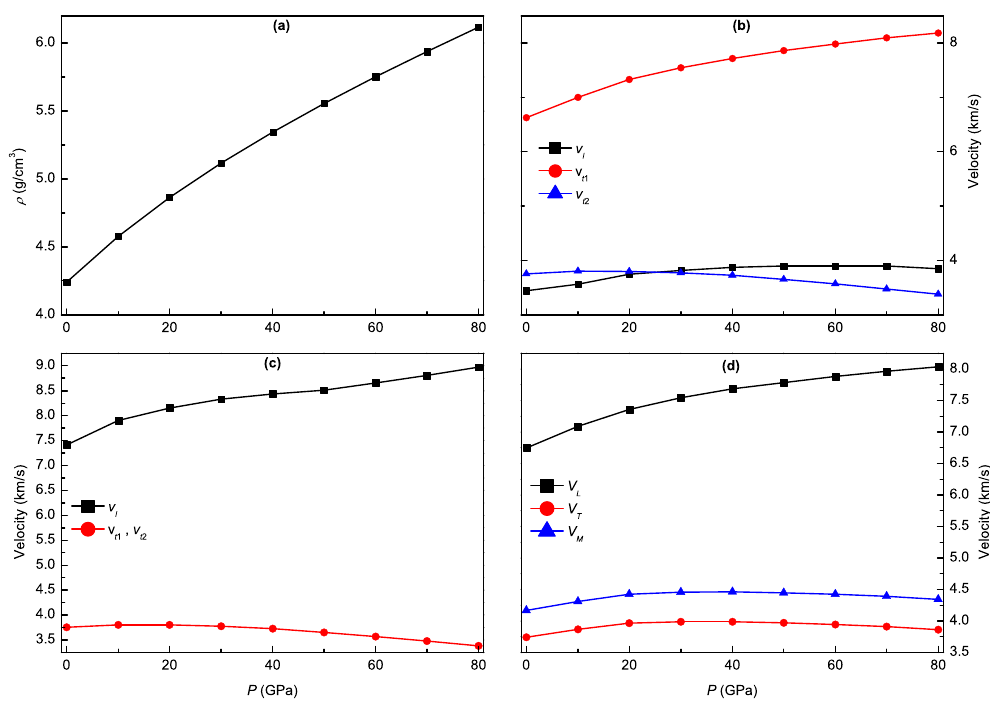
Figure 10. Mass density ρ ( a ), longitudinal and transverse sound velocities v l , v t 1 , and v t 2 in the [100] ( b ) and [001] ( c ) principle directions, and polycrystalline longitudinal, transverse, and average sound velocities V L , V T , and V M ( d ) as a function of pressure for Ti 3